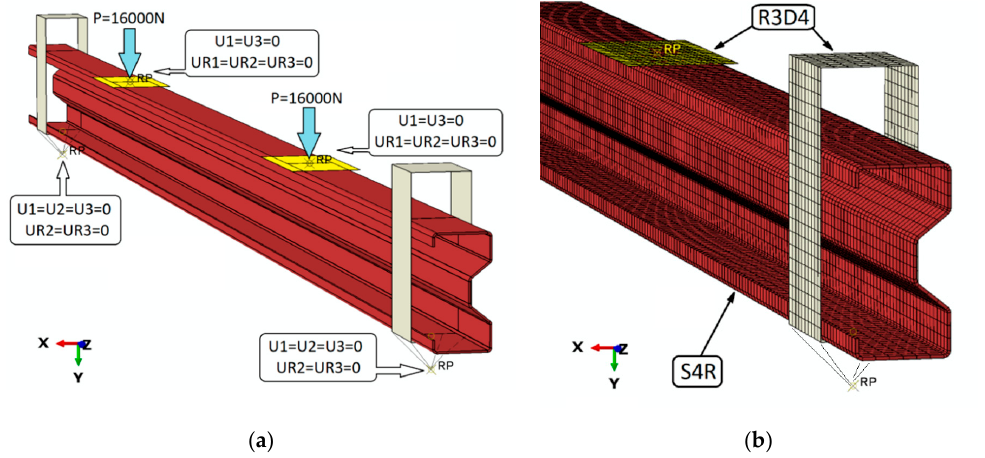
Figure 11. Numerical model for the third stage of study: ( a ) boundary conditions, and ( b ) mesh Figure presentation.